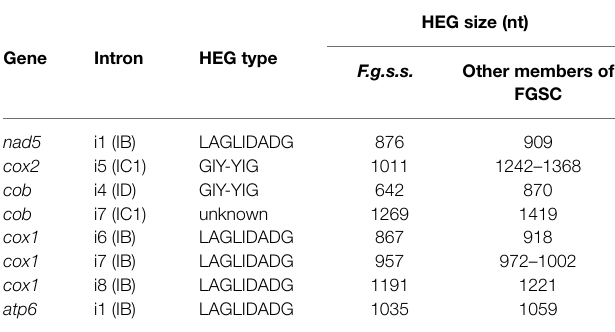
TABLE 1 | List of HEGs allowing differentiation of F.g.s.s. based on size